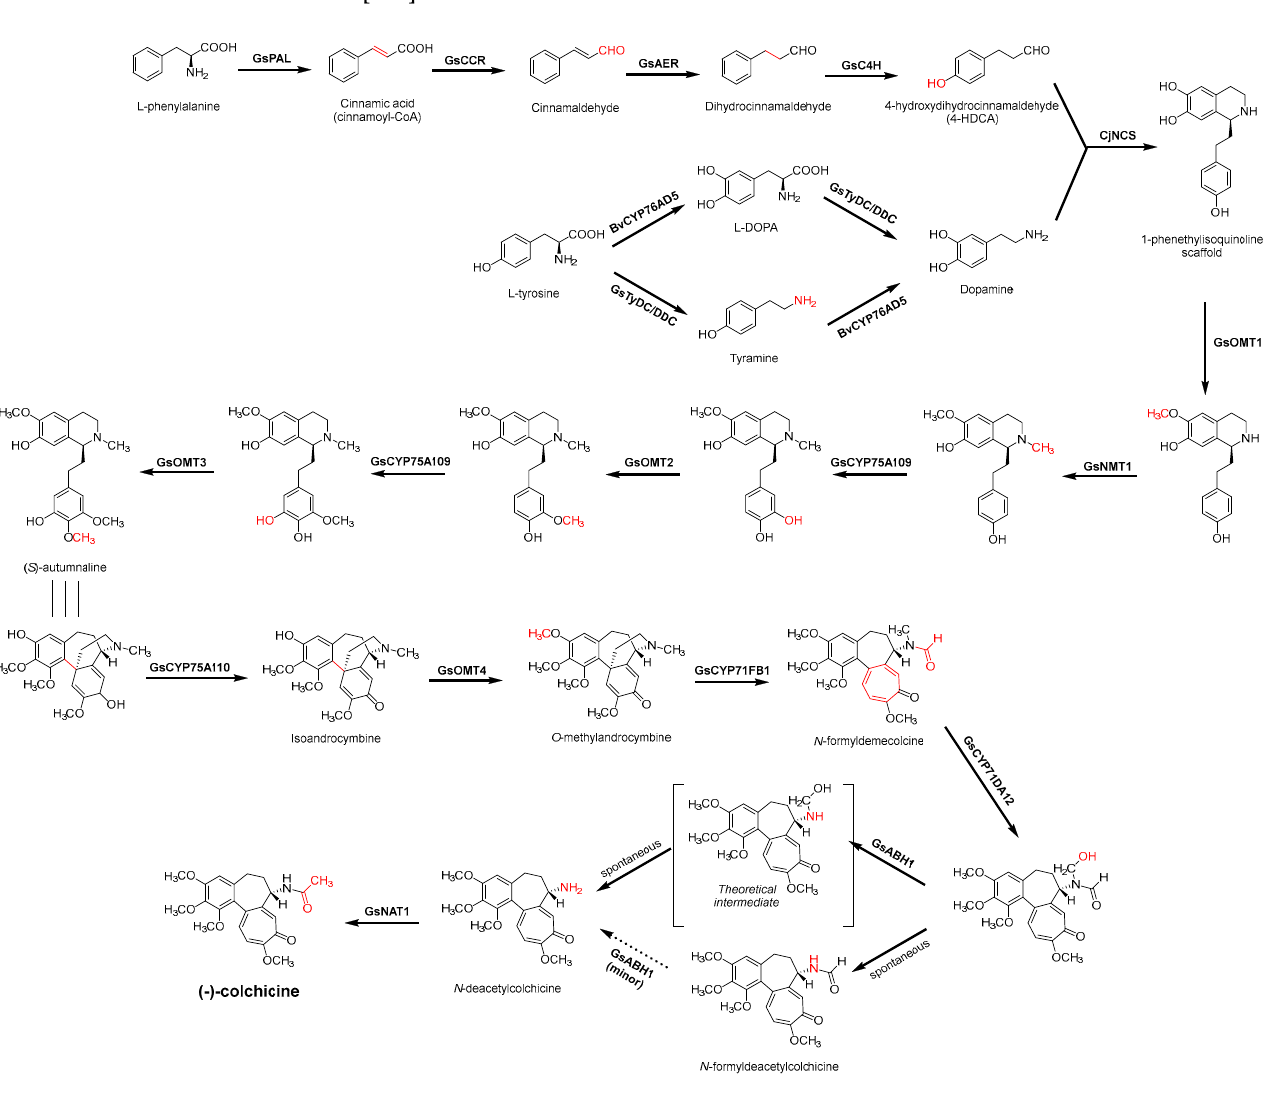
Figure 6. Biosynthesis pathway of alkaloid antimicrobial agent (-)-colchicine. GsPAL, phenylalanine ammonia-lyase; GsCCR, cinnamoyl-CoA reductase; GsAER, alkenal reductase; GsC4H, cinnamate